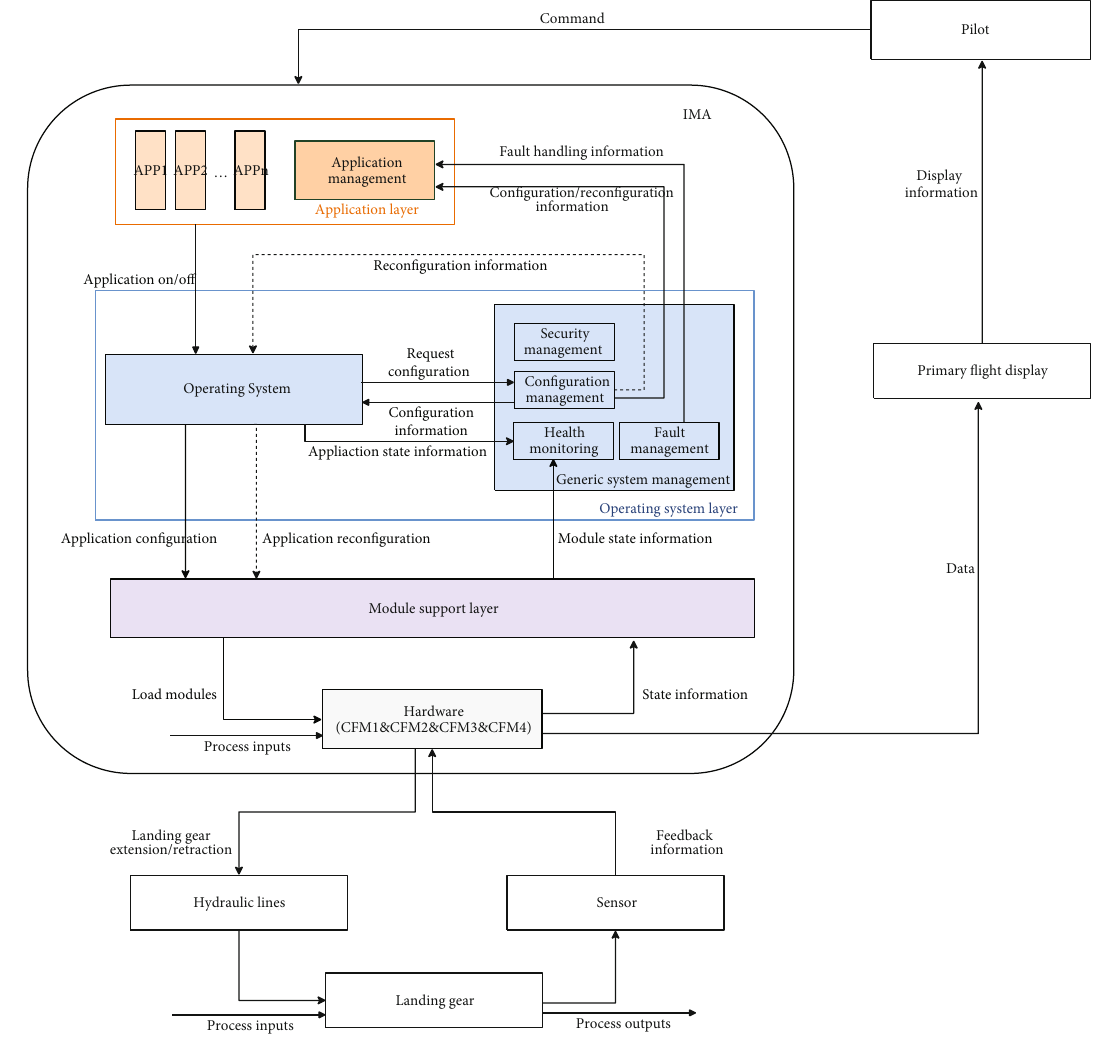
Figure 6: Safe control structure of the hosted